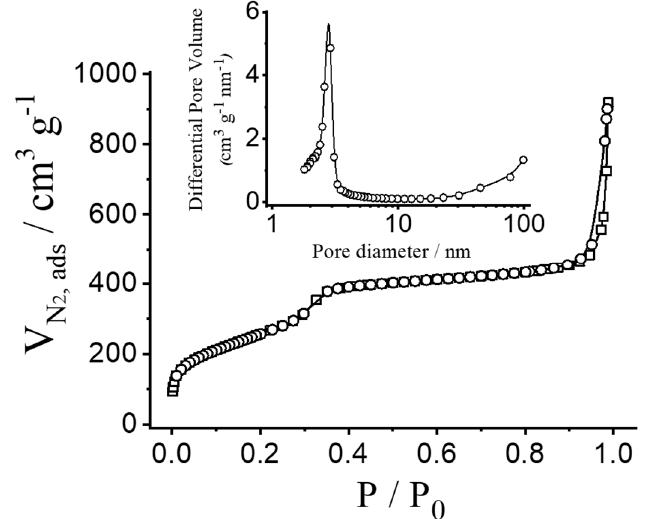
Figure 3. N 2 adsorption–desorption isotherms for calcinated MCM-41 nanoparticles. Inset: pore size distribution of MCM-41 nanoparticles.